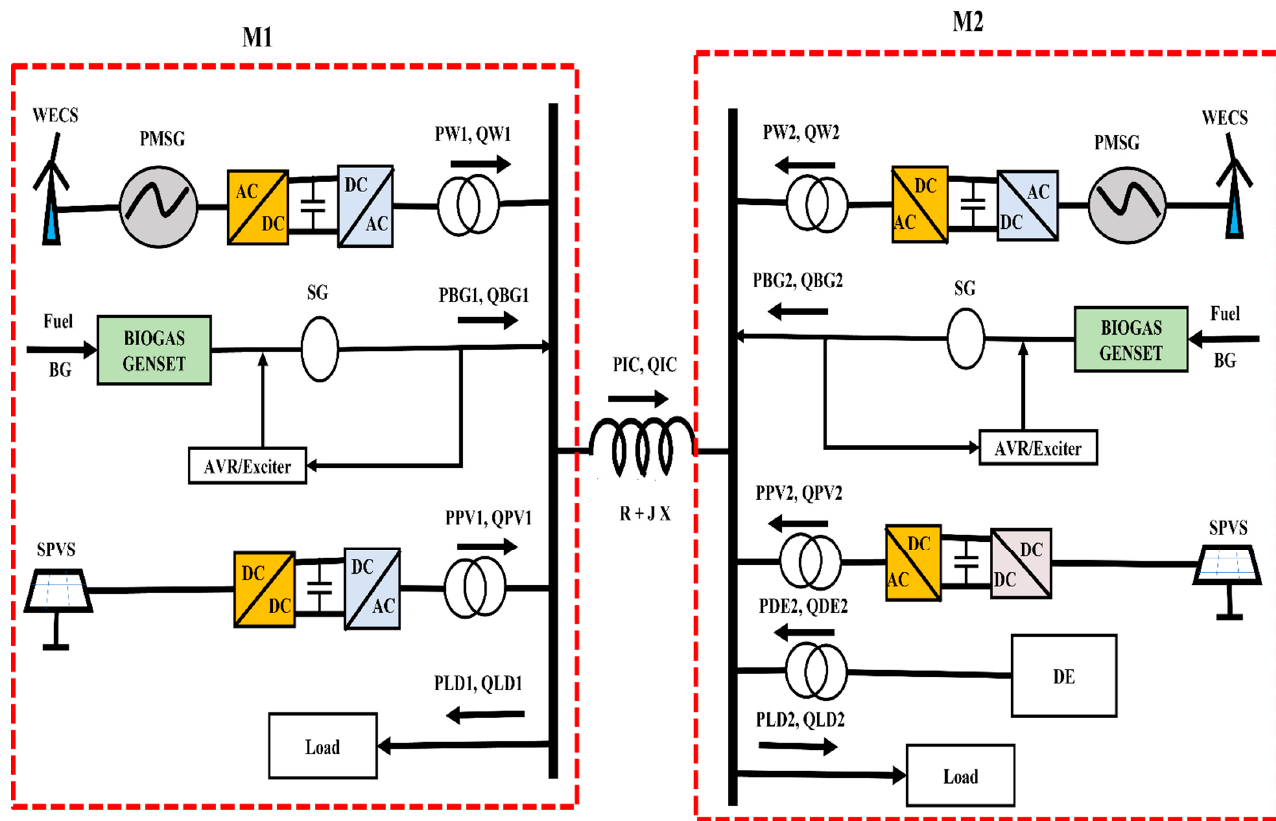
Figure 1. SLD of interconnected microgrid system. Equations (1) and (2) can be used to express the real and reactive power balance at a steady state.